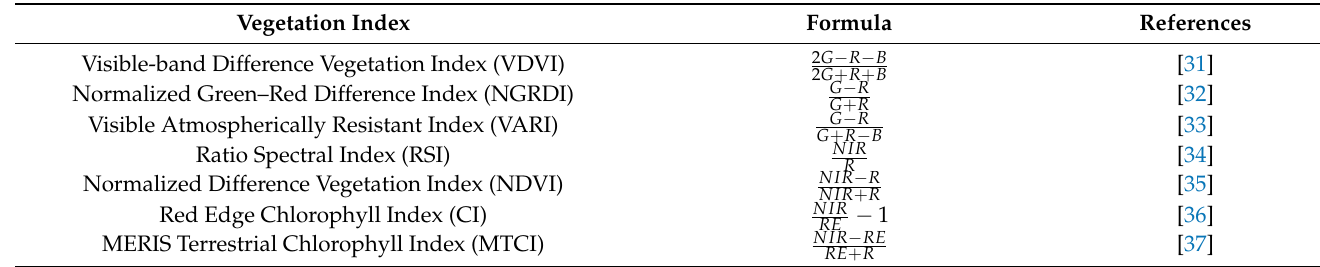
Figure 3. RGB image of different periods in target area. Table 1. The calculation formula of the remote sensing spectral index of the target